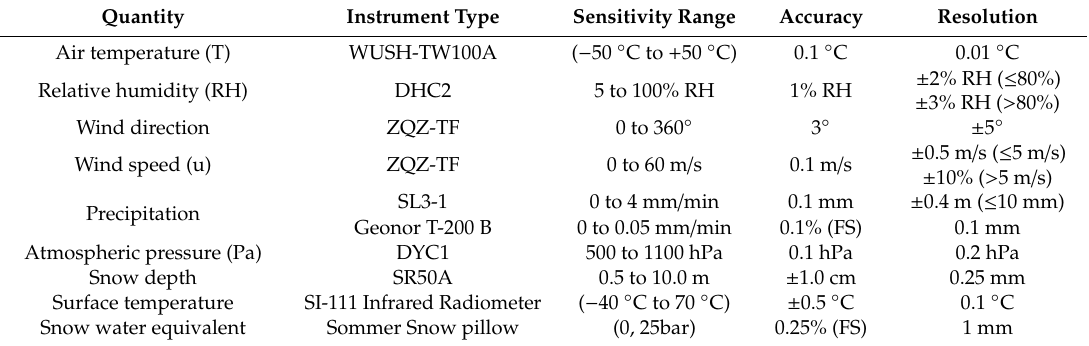
Table 2. Technical specifications of the sensors used at the three automatic snow and weather stations.